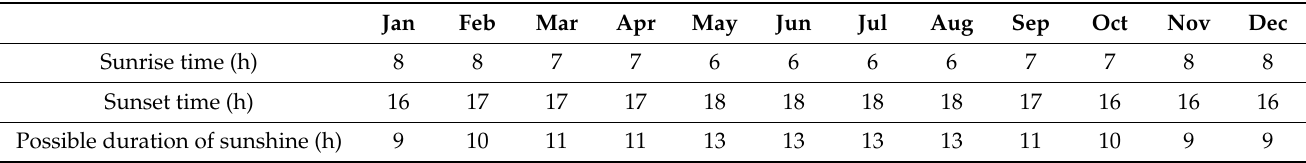
Table 4. Sunrise time, sunset time, and possible duration of sunshine during each month in the study area.